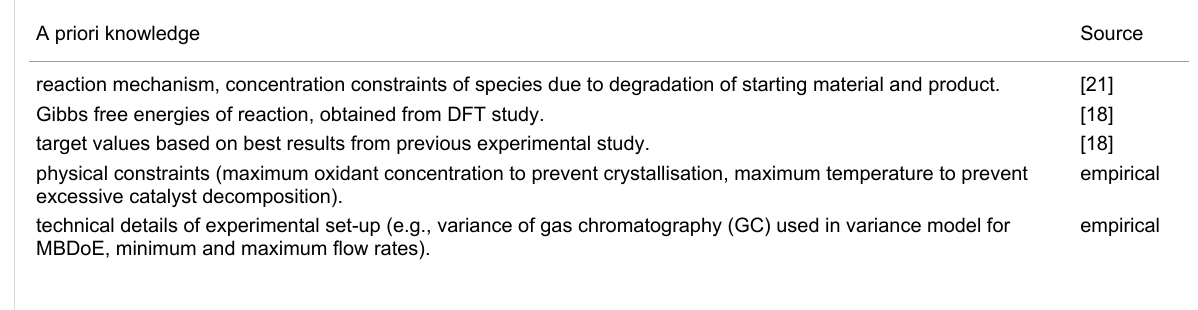
Table 1: Details of information considered as a priori knowledge in this study and source of this knowledge.